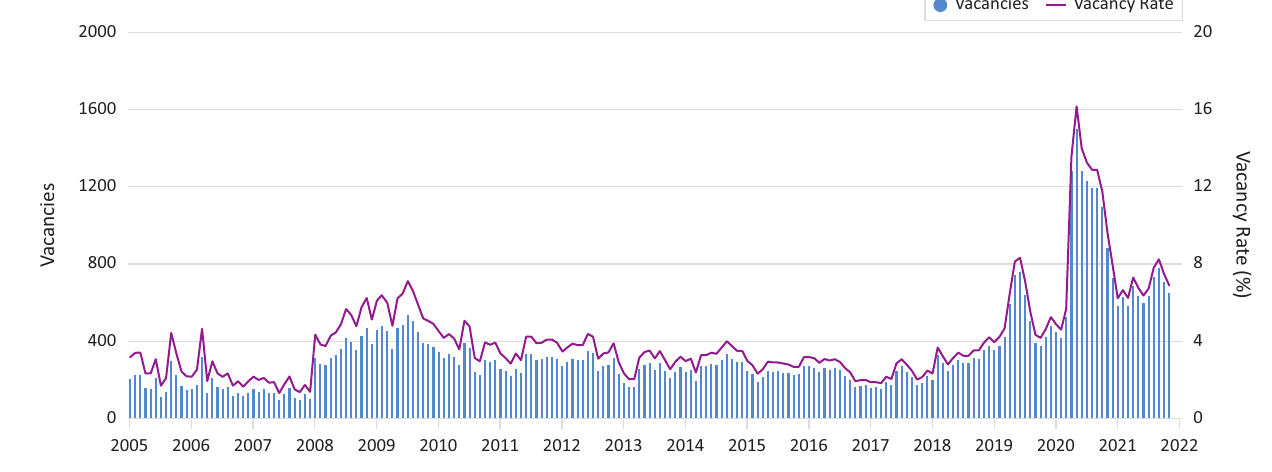
Figure 2. Residential vacancy rates (2005–2021). Source: SQM Research